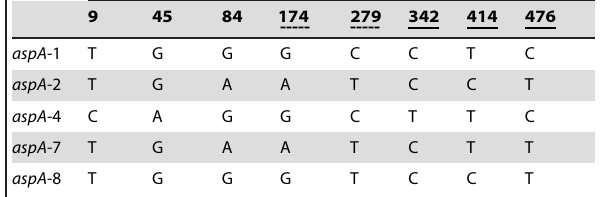
a The numbering starts at the first nucleotide of each comparison fragment for each locus on the C. jejuni MLST database website. Numbers not underlined are in the left fragment and numbers with solid underling are in the right